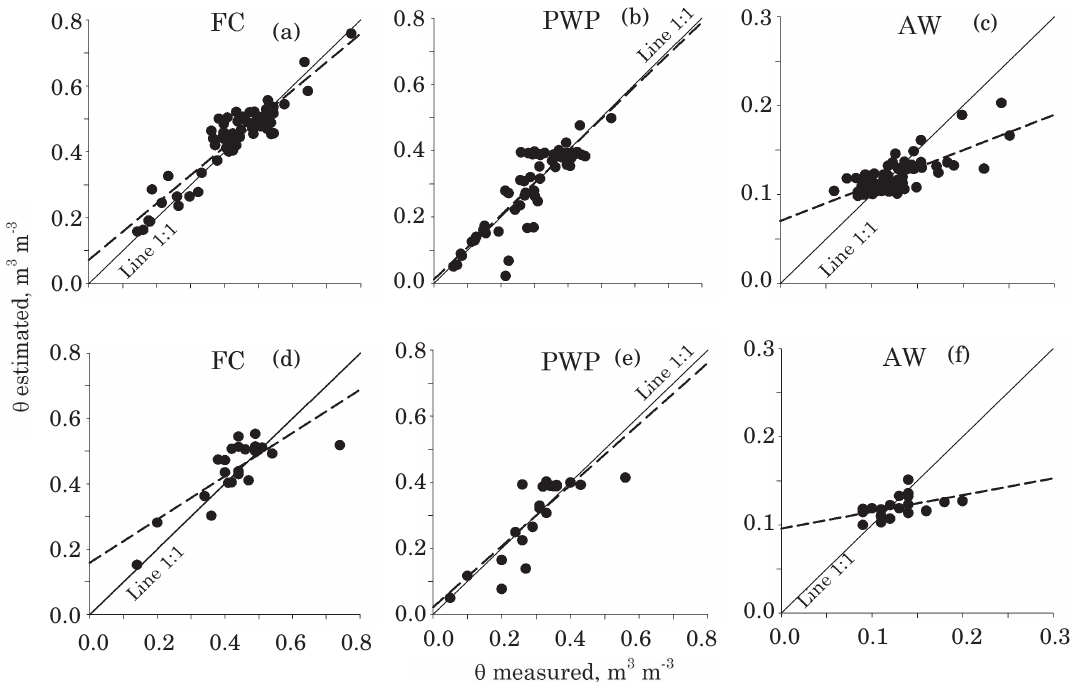
Figure 7. Field capacity (FC), permanent wilting point (PWP) and available water content (AW) measured and estimated by PTFs of the simple model: Particle size distribution of the soil, organic matter and their interactions for the generation database (a, b, c) and validation database (d, e, f) for surface horizons of soils of the State of Santa Catarina.